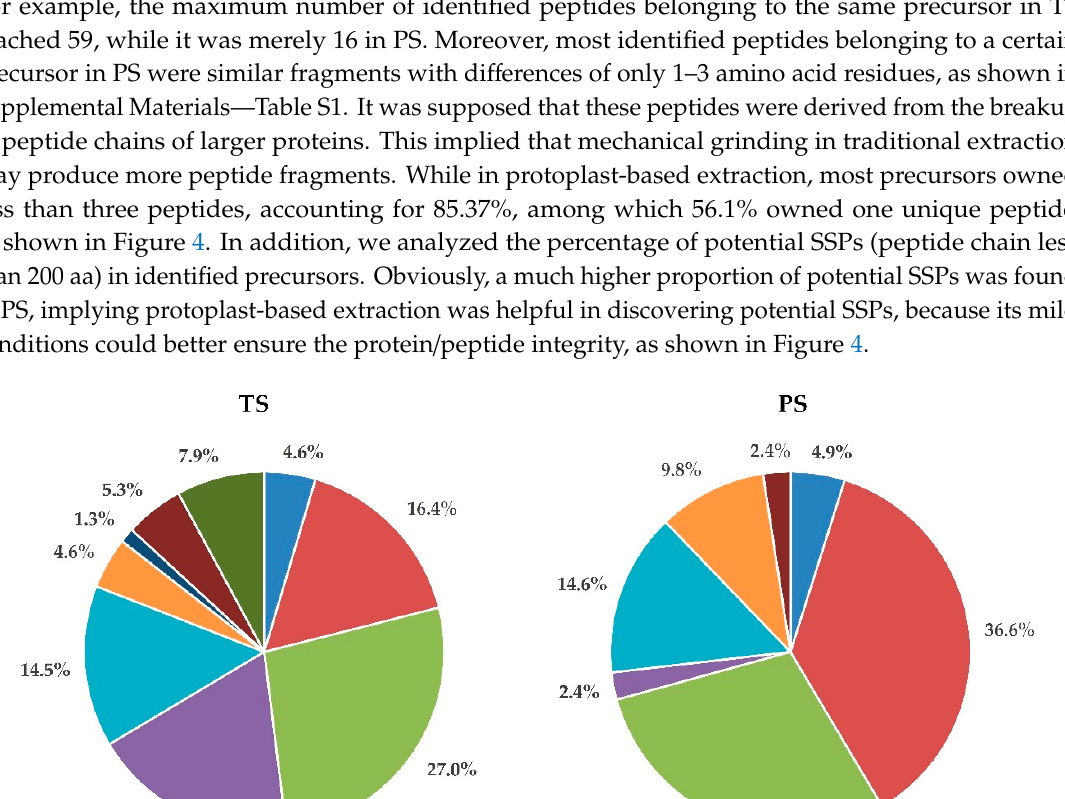
5 of 12 Figure 3. Peptides extracted from leaf tissue and protoplasts. ( a ) Protoplasts of Arabidopsis leaf; ( b ) total-protein (including peptides) yield extracted from tissues (TS) and protoplasts (PS); ( c ) total- protein (including peptides) content of tissues (TS) and protoplasts (PS); ( d ) peptide (<10 kD)